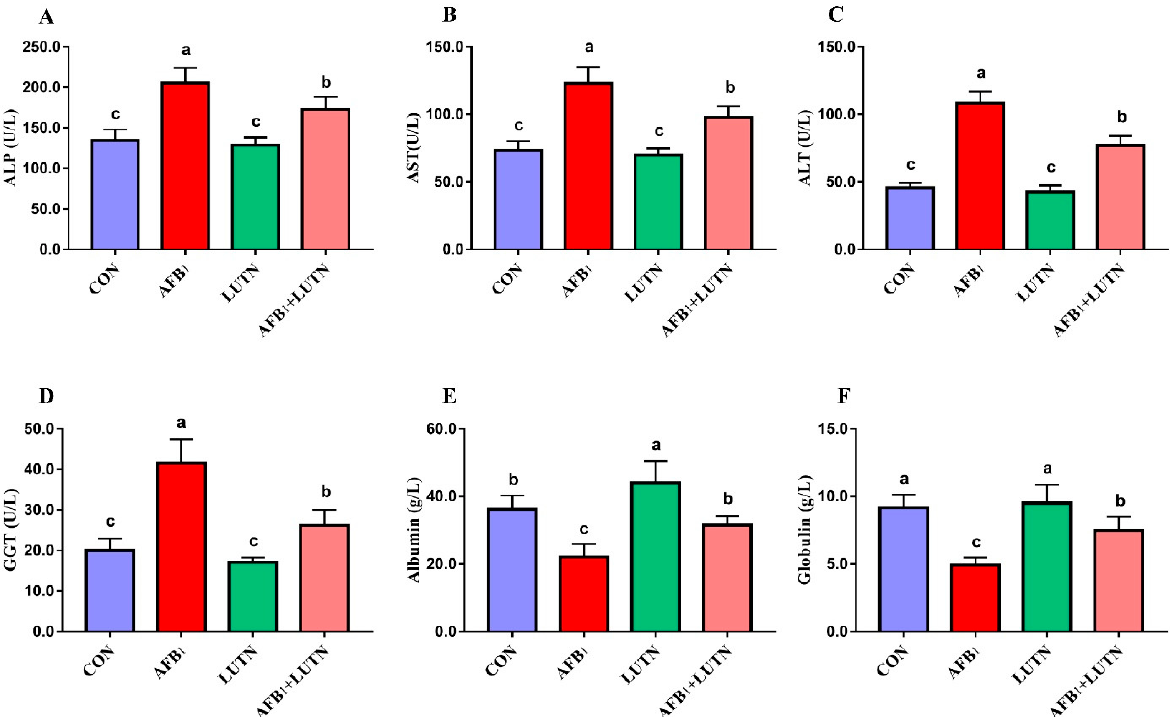
Figure 2. Luteolin treatment prevents AFB 1 -induced liver damages in mice. ( A ) alkaline phosphate (ALP), ( B ) aspartate aminotransferase (AST), ( C ) alanine aminotransferase (ALT) ( D ) gamma-glutamyl transferase (GGT), ( E ) albumin and ( F ) globulin. The results are presented as mean ± SD ( n = 6). a–c Columns with different lowercase letters indicated significant differences between the compared groups ( p < 0.05).